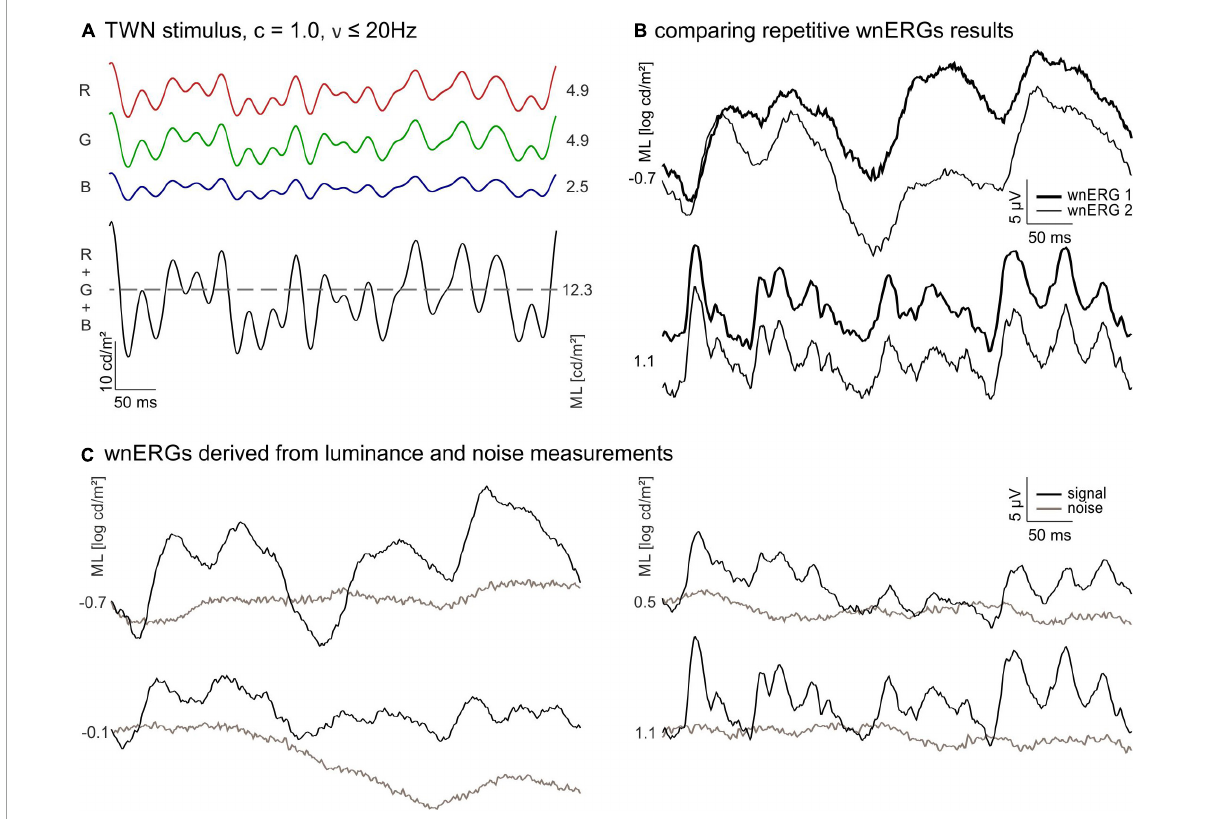
FIGURE1 White noise electroretinograms (wnERGs) in mice. (A) The temporal white noise (TWN) stimulus is generated by three light emitting diodes (LEDs) [red (R), green (G), and blue (B)]. Their mean luminances (ML) adds up to the ML of the stimulus (black). The Michelson contrast of the stimulus is 100% and no frequencies above 20 Hz were presented. (B) Two repeated wnERGs measured at the same ML (thin and thick line) for two different MLs. The responses are averages from all animals. (C) Repeated white noise electroretinogram (wnERG) recordings of (B) are further averaged for different MLs (black), corresponding noise measurements for each ML are shown in